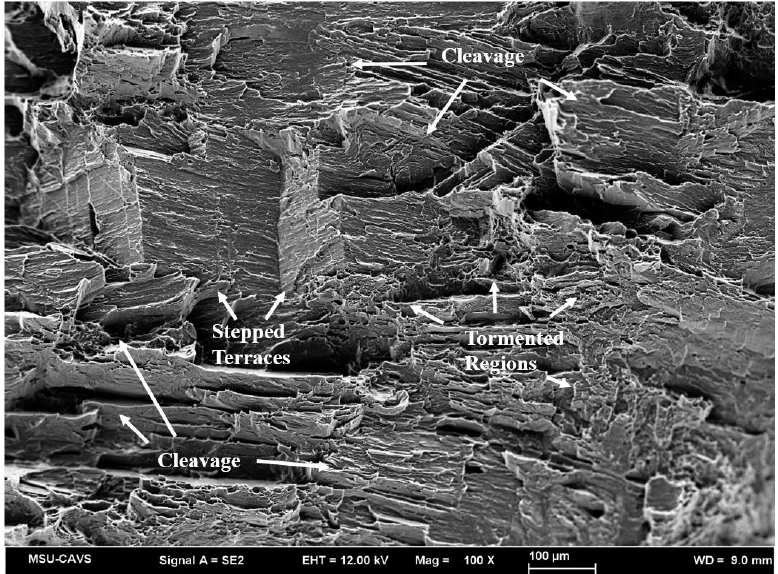
Figure 12. Micrograph shows evidence of dual phase fracture. Cleavage and stepped terraces formed from twin interactions caused brittle failure, whereas the tormented regions show ductile